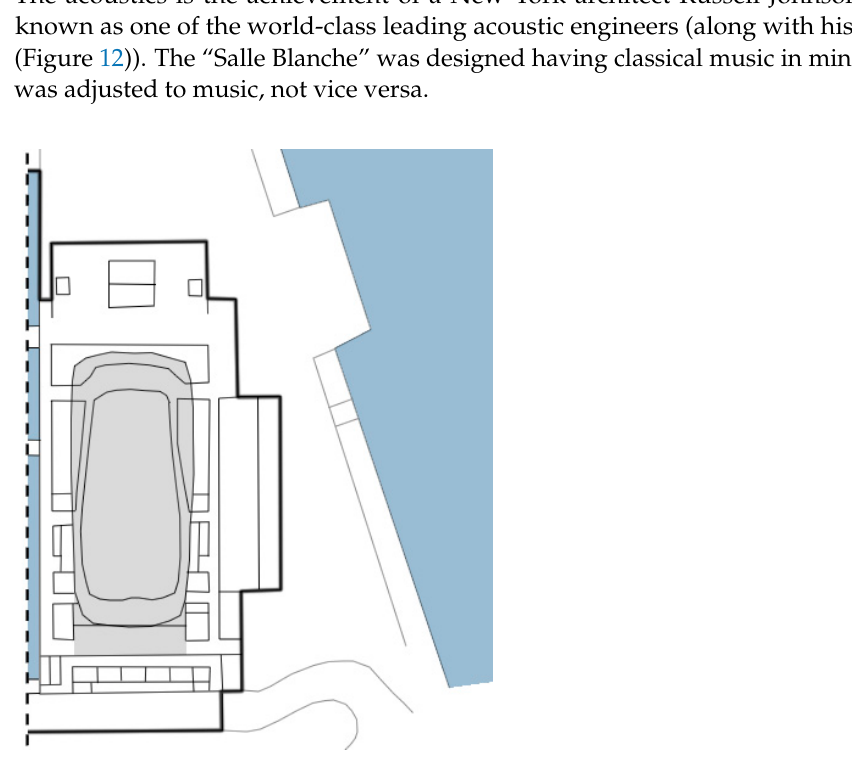
Figure 12. Salle Blanche in Kultur- und Kongresszentrum Luzern, graphic processing by E. Latusek.